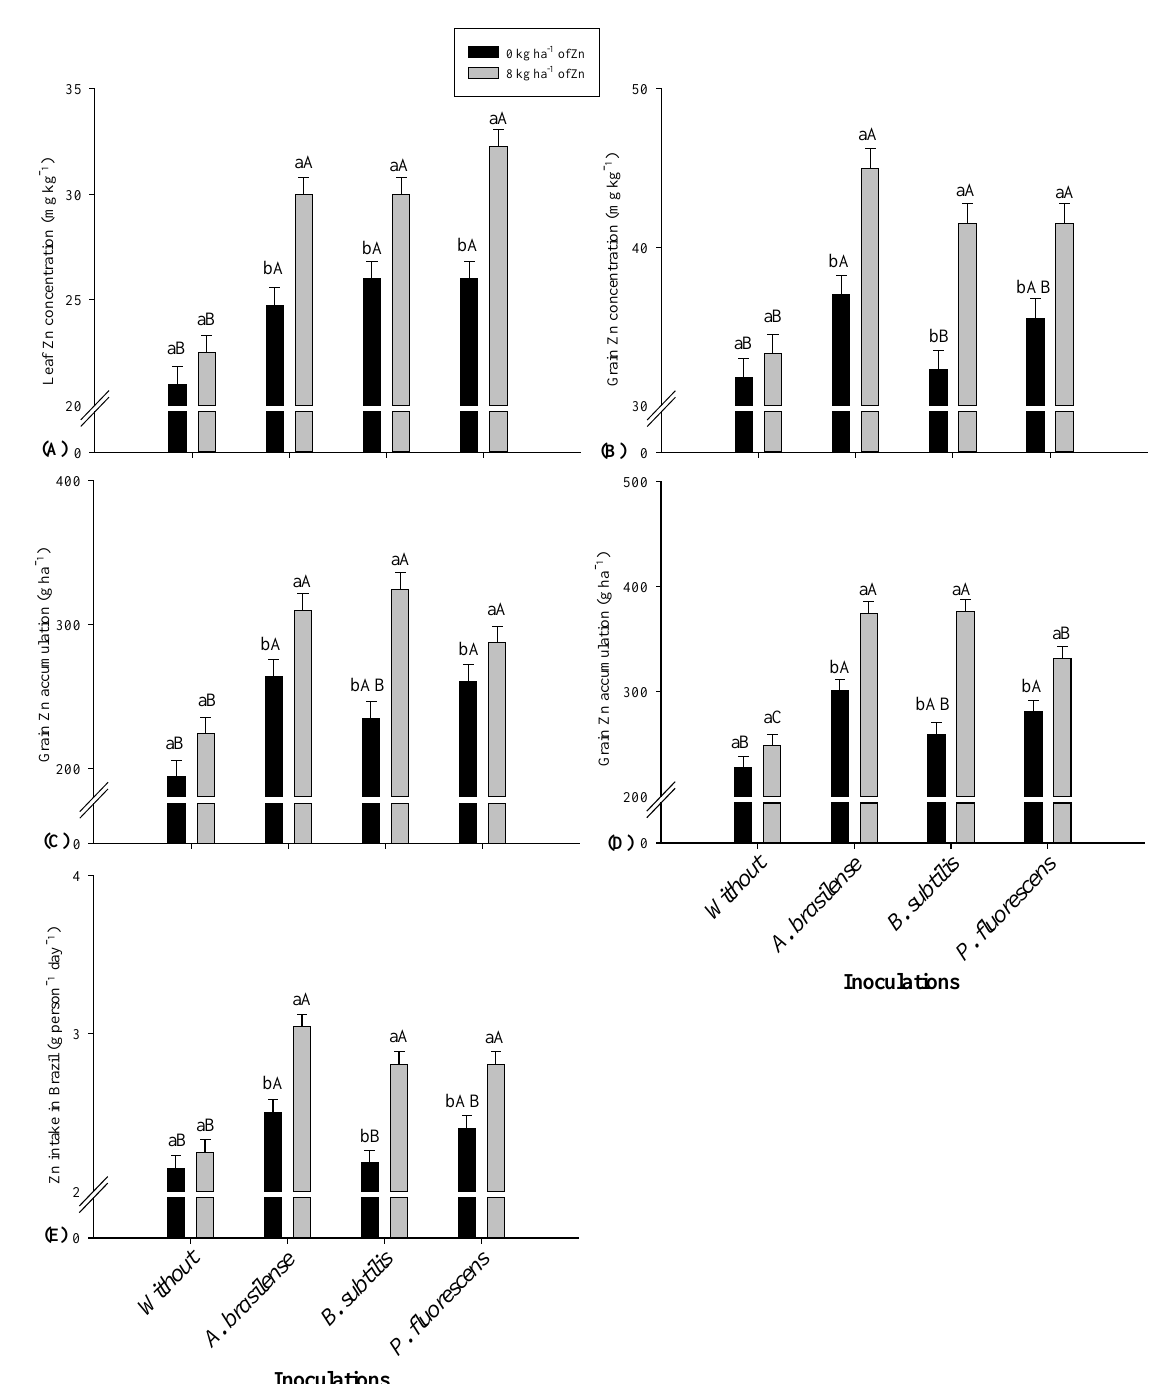
Figure 2. Leaf zinc concentration ( A ) and grain zinc concentration ( B ) in 2020–2021, respectively, and grain zinc accumulation in 2019–2020 ( C ) and 2020-2021 ( D ), and estimated daily zinc intake in Brazil in 2020 − 2021 cropping maize season ( E ) as function of residual Zn doses and diazotrophic bacteria. Without = control (no inoculation). The uppercase letters are used for inoculation interactions within each level of soil applied residual Zn whereas lowercase letters are used for the interactions of Zn doses (presence and absence) within each inoculation treatment. The identical alphabetic letters do not differ from each other by Tukey test ( p < 0.05) for Zn doses and inoculations in 2019–2020 and 2020–2021. Error bars indicate standard error of the mean ( n = 4